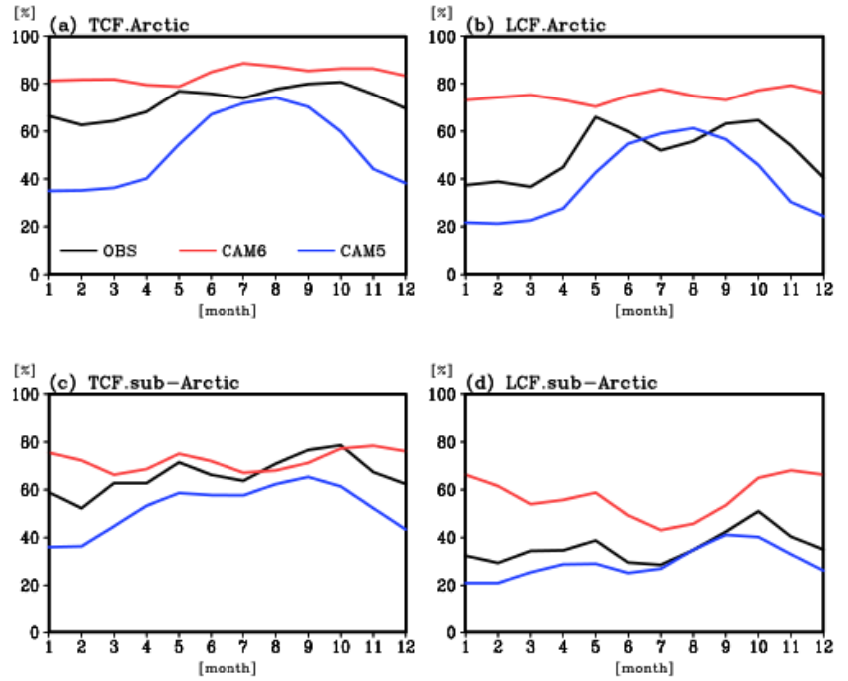
Figure 3. Annual cycles of the ( a ) total cloud fraction (TCF) and ( b ) low cloud fraction (LCF) averaged over the Arctic from CALIPSO–GOCCP observations averaged from June 2006 to November 2010 (black line), CAM6 (red line), and CAM5 (blue line). The CALIPSO–GOCCP observations were averaged from June 2006 to February 2015, and the model results are the means of AMIP simulation results for 36 years, from January 1979 to February 2015. ( c , d ) are the same as ( a , b ), except for over the sub-Arctic area.